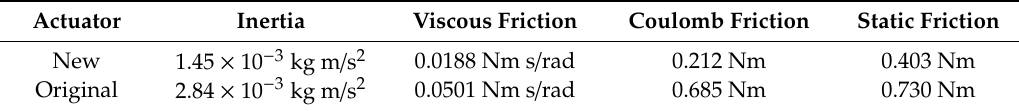
Table 4. Inertia and friction parameters characterizing the backdrivability of the actuator.